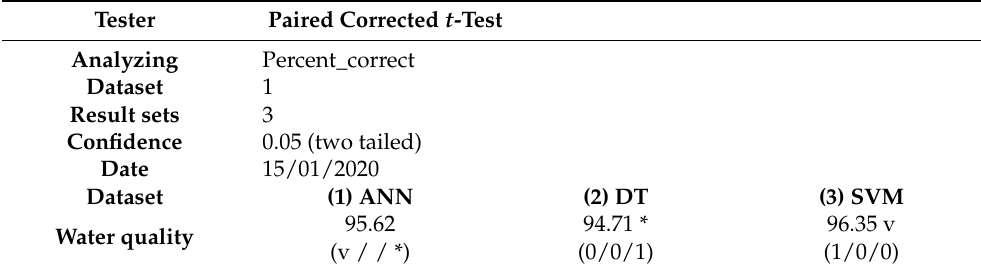
Table 12. The paired corrected t -test results. * indicates that the result is different from the ANN. Tester Paired Corrected t -Test